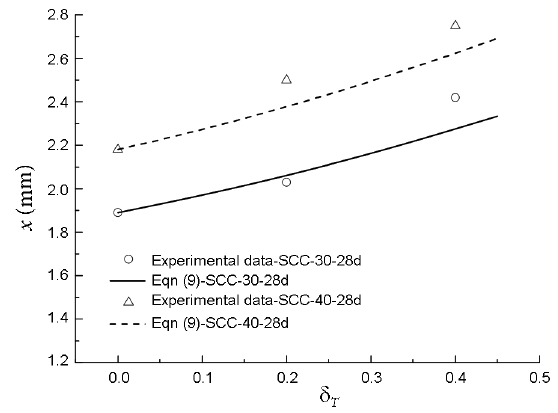
Figure 12. Comparison between the computed results from Eqn (9) and the experimental data from Zheng and Huang